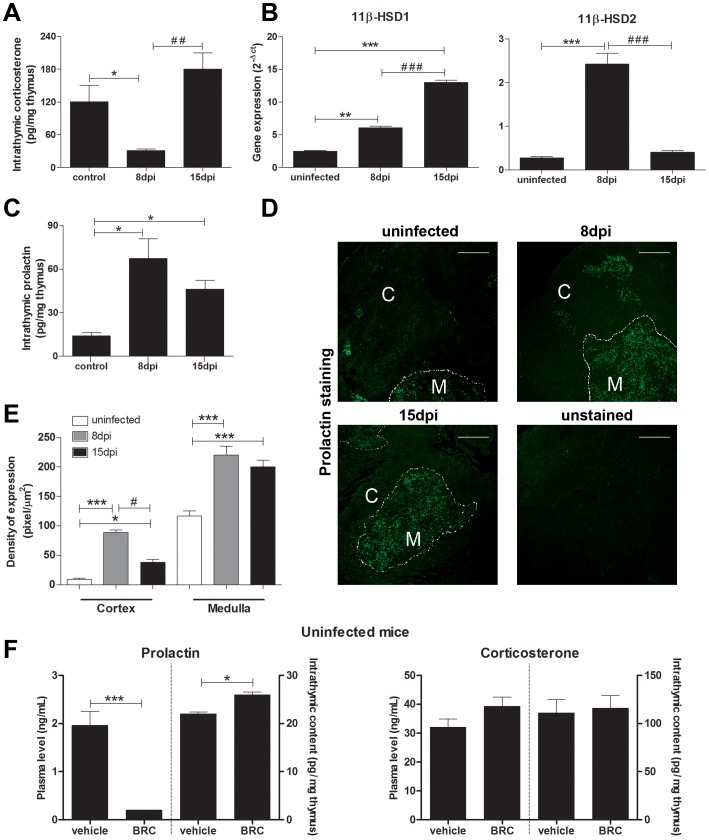
The intrathymic production of glucocorticoids and prolactin is differentially modulated by
T. cruzi infection.Panel A reveals the transient decrease of GC production whereas panel B
shows the differential gene expression levels of the enzymes 11β-HSD1 and 11β-HSD2. In
parallel with the transient decline in GC production, there is a transient increase in prolactin
contents as shown in panel C. Intrathymic in situ prolactin labeling
is seen in panel D, through representative confocal microscopy images of thymuses from
uninfected and infected mice. In this panel, thymuses were stained with the anti-PRL antibody,
whereas the lower right box corresponds to the negative control for the immunostaining in which the
anti-PRL was replaced by an unrelated goat IgG. The quantification of fluorescence intensity,
separately done in the cortex and medulla of thymic lobules, revealed that the rise in PRL contents
occured in both regions, as seen in panel E. As expected, bromocriptine (BRC), as an
inhibitor of prolactin secretion by the anterior pituitary gland, promotes a shutdown of systemic
prolactin levels (compared to the treatment with the vehicle alone), as measured in the blood (panel
F left). However, injection of this compound into normal mice does not induce a
decrease in the intrathymic PRL contents, as seen in panel F, when comparing BRC-
versus vehicle-treated animals. Indeed, a slight (but significant) increase of PRL in the thymus
could be detected in BRC-treated animals. Both intrathymic and systemic corticosterone levels
remained unchanged in these animals (panel F, right). The intrathymic levels of
corticosterone were determined by radioimmunoassay, whereas prolactin contents were measured by
ELISA in thymus lysates from normal and infected (8 and 15 dpi) mice. In both cases, results were
expressed as pg/mg thymus. The transcript levels of 11β-HSD1 and 11β-HSD2 genes were
ascertained by quantitative real time PCR. The results represent the amount of transcripts, in
relation to the housekeeping gene RPL-13 as 2−Δct. As for the confocal
microscopy, the original magnification was ×200, with the scale bars = 20
µm. Graphs in panel E correspond to quantification of PRL contents, defined by
immunofluorescence in 5 microscopic fields of each thymus from uninfected
(n = 3) or infected animals (n = 3), with data being
represented as pixels/µm2. Male mice were daily given s.c. BRC (100
µg/animal) during three days, when they were sacrificed and their thymuses and plasma
obtained. Intrathymic and plasma PRL contents were measured by ELISA, with data being expressed as
ng/mL in sera, and as pg/mg in the thymus. Statistically significant differences (p<0.05) between
uninfected versus infected (*) or between 8 and 15 dpi (#) mice.
*p<0.05; **p<0.01, ***p<0.001.